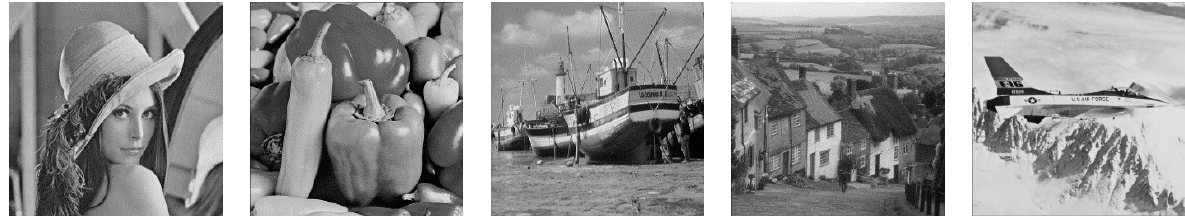
Figure 11. Pictures used for testing in experiments.